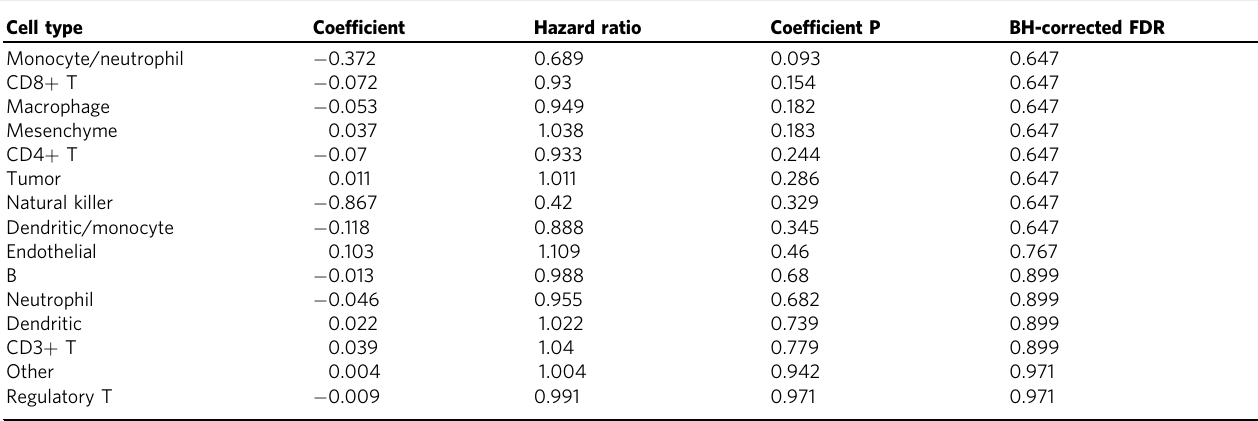
Table 2 Immune composition Cox regression results for recurrence.